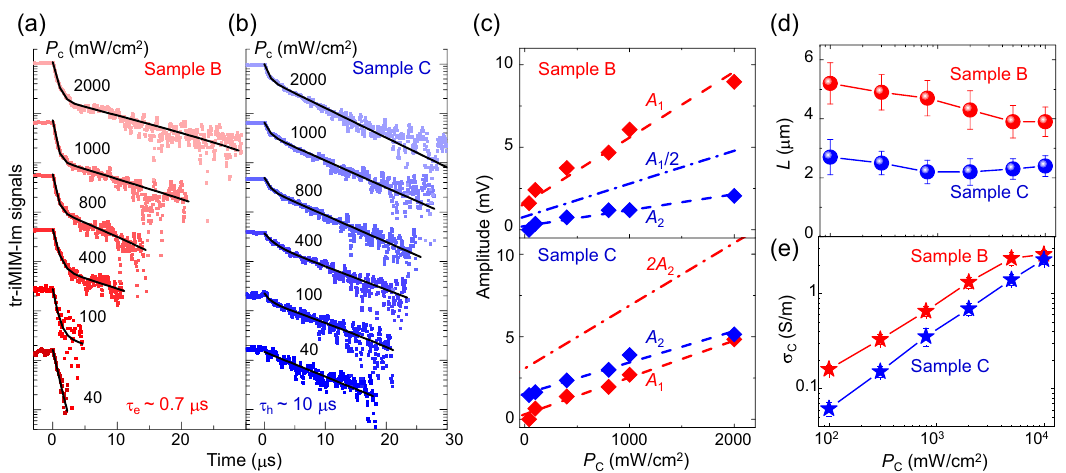
Fig. 4 Power-dependent iMIM results. a tr-iMIM signals on Sample B and b Sample C under various laser powers. Signals below the noise level are truncated for clarity. c Power-dependent A 1 and A 2 in Sample B (upper panel) and Sample C (lower panel). The dash-dotted lines are A 1 /2 (Sample B) and 2 A 2 (Sample C) for comparison with the plain perovskite Sample A, which shows A 1 / A 2 ~ 2. d Power-dependent diffusion lengths and e photoconductivity at the center of the illumination spot in both